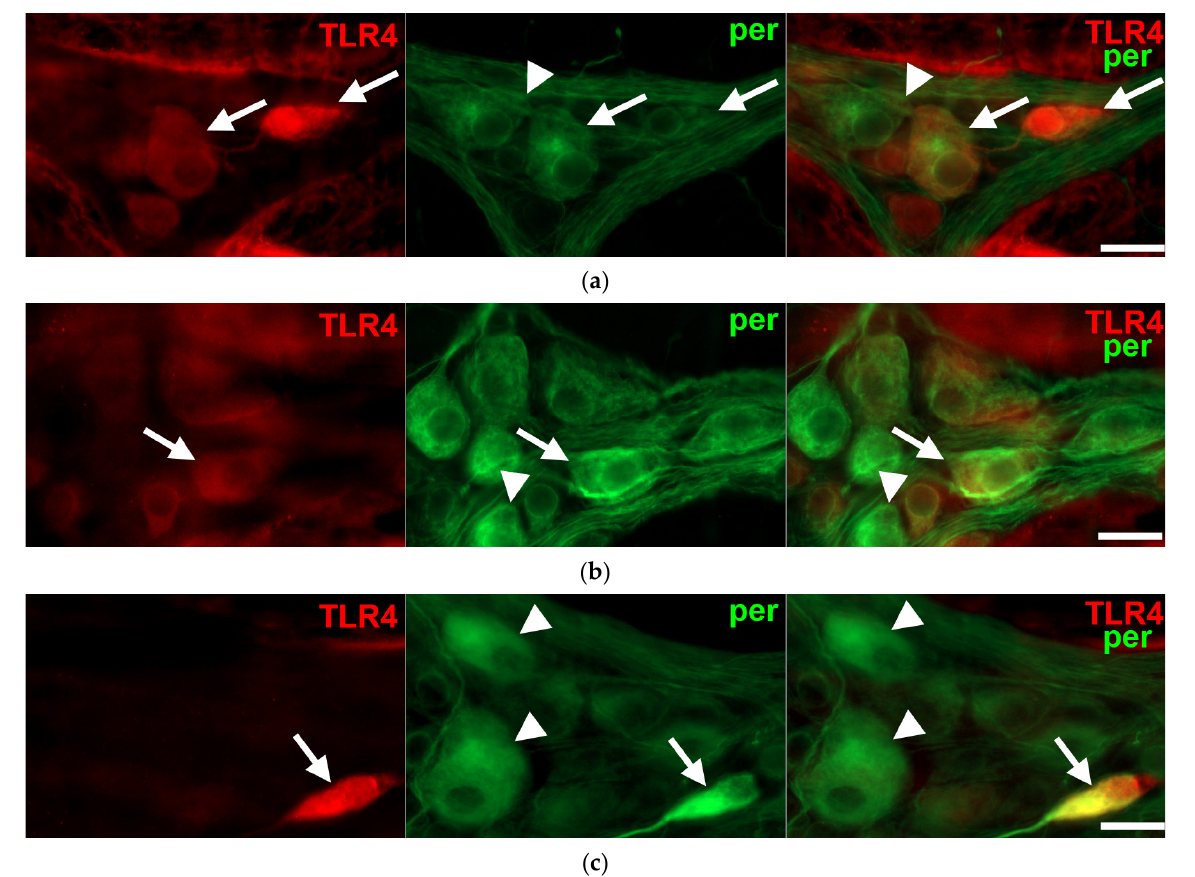
Figure 3. Representative fluorescent micrographs of whole-mount preparations of myenteric ganglia from the duodenum ( a ), ileum ( b ) and colon ( c ) of a diabetic rat after TLR4-peripherin double-labelling immunohistochemistry. Peripherin was used as a pan-neuronal marker to label myenteric neurons. Arrows—TLR4-immunoreactive myenteric neurons, arrowheads—myenteric neuron, scale bars: 20 µm.